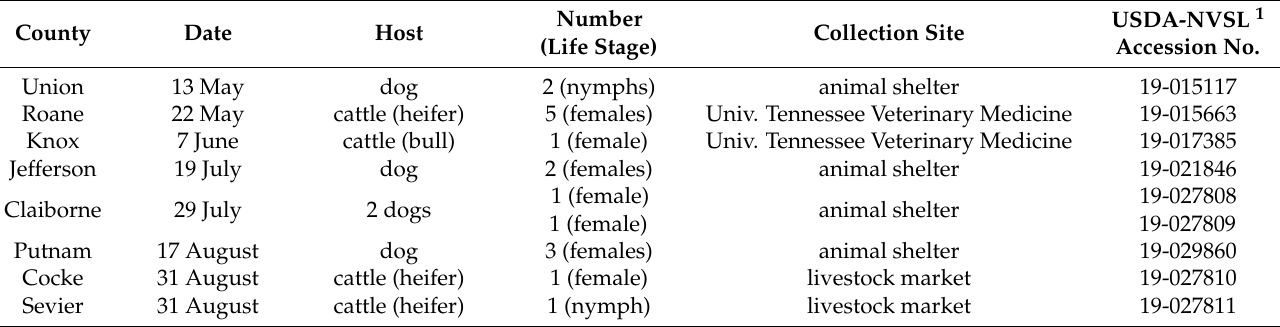
Table 2. Chronological summary of stakeholder submissions of first collection records for Haemaphysalis longicornis ticks originating in eight counties of middle and eastern Tennessee, 2019–2020. Bisected specimens are retained as vouchers at the University of Tennessee Medical and Veterinary Entomology